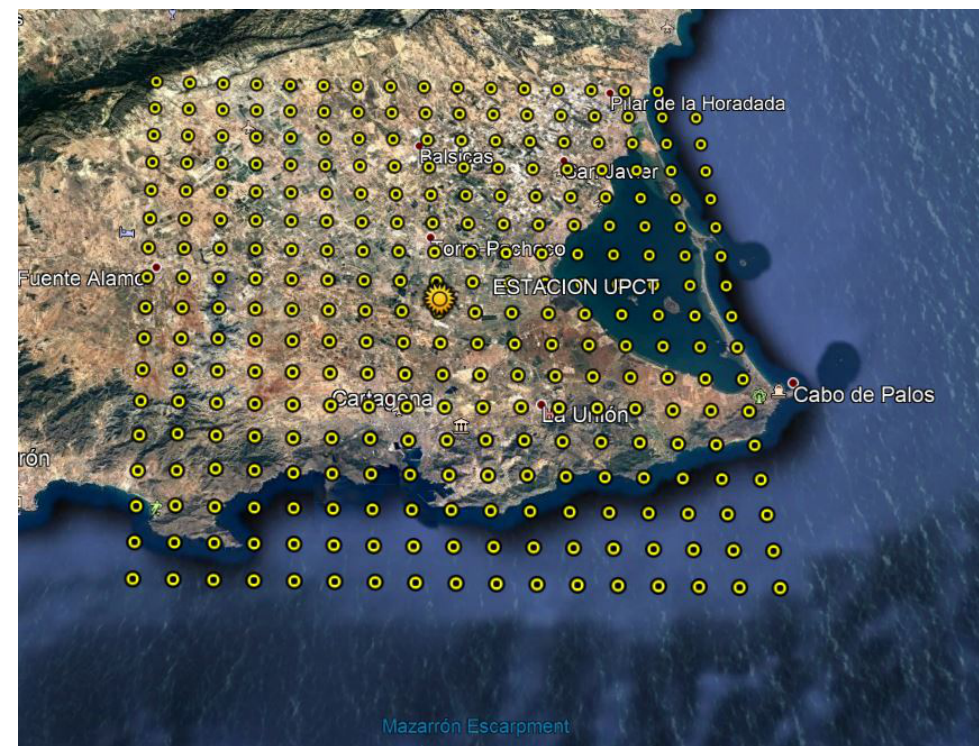
Figure 5. Case example: general overview and datasets (Region of Murcia,